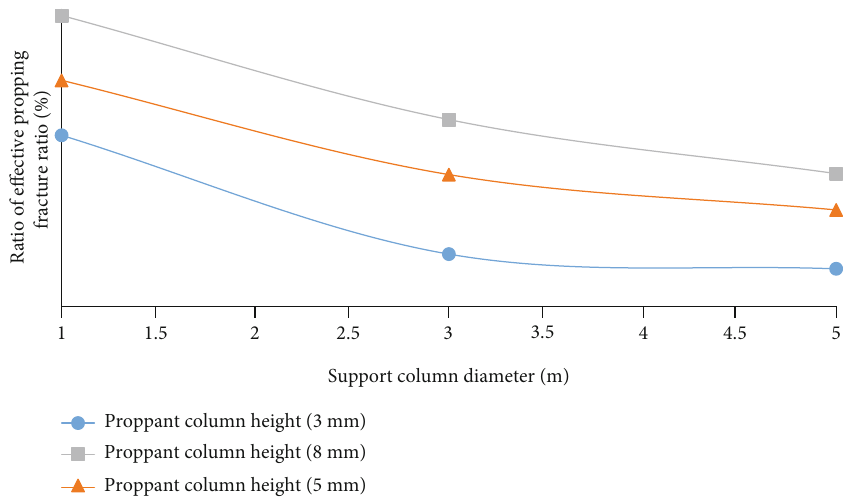
Figure 43: The e ff ect of proppant diameter on e ff ective supporting fractures.